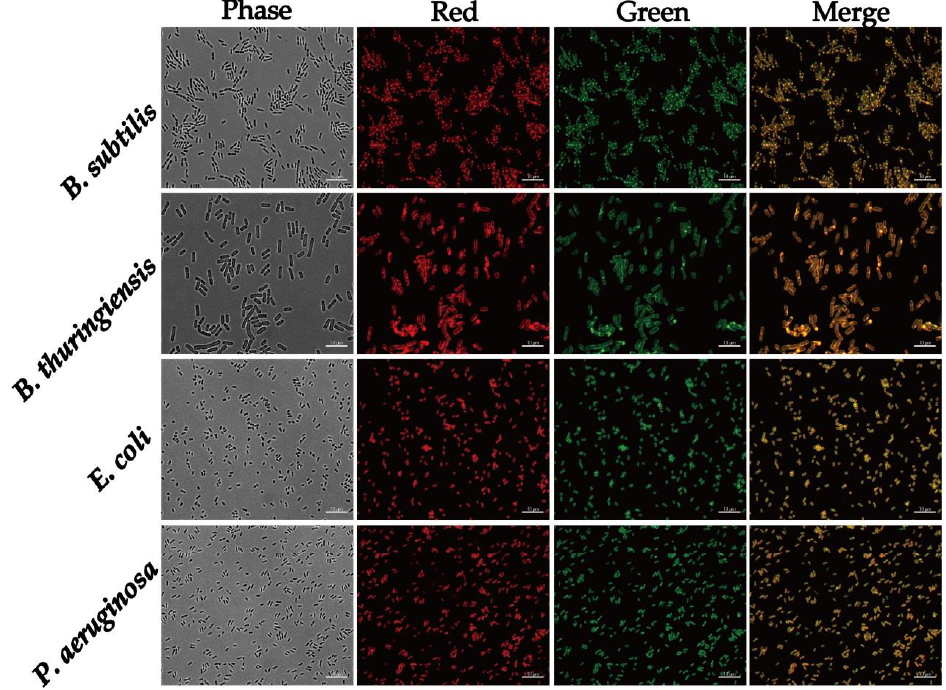
Figure 8. Fluorescence microscopy images of B. subtilis, B. thuringiensis, E. coli and P. aeruginosa cells stained with PEG 6000 /CD at 100 ppm. TRITC filter detected red color and FITC filter detected green color. Scale bar represents 10 μm. Nanomaterials 2020